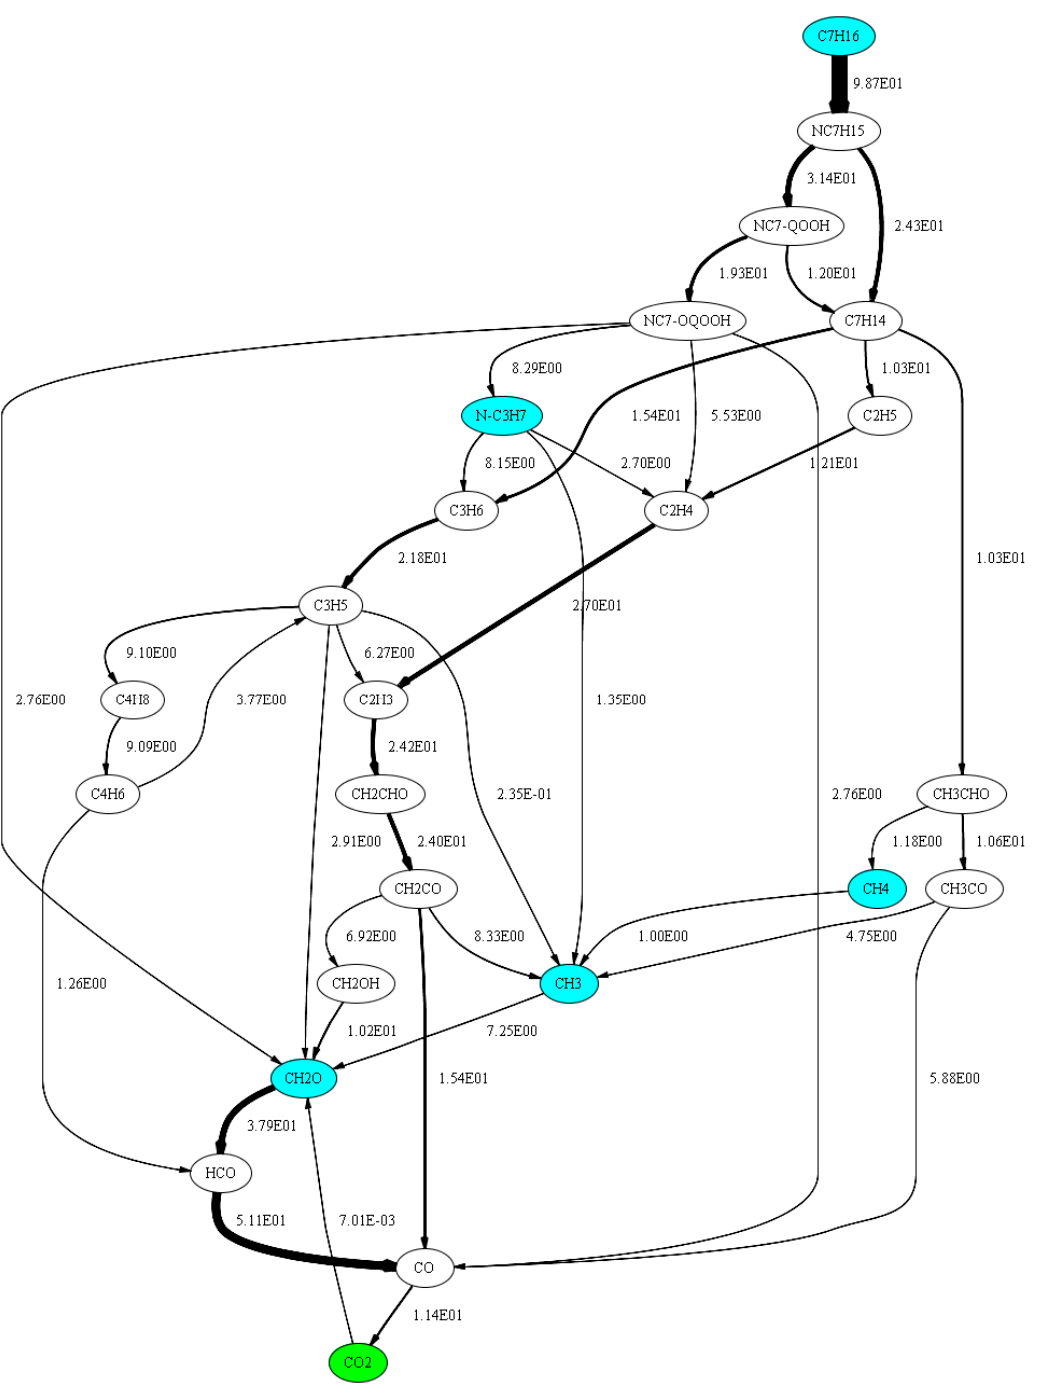
Figure 20. Flow analysis for carbonaceous species performed with an n -heptane-air mixture at φ = 1, T = 950 K and p = 60 bar.